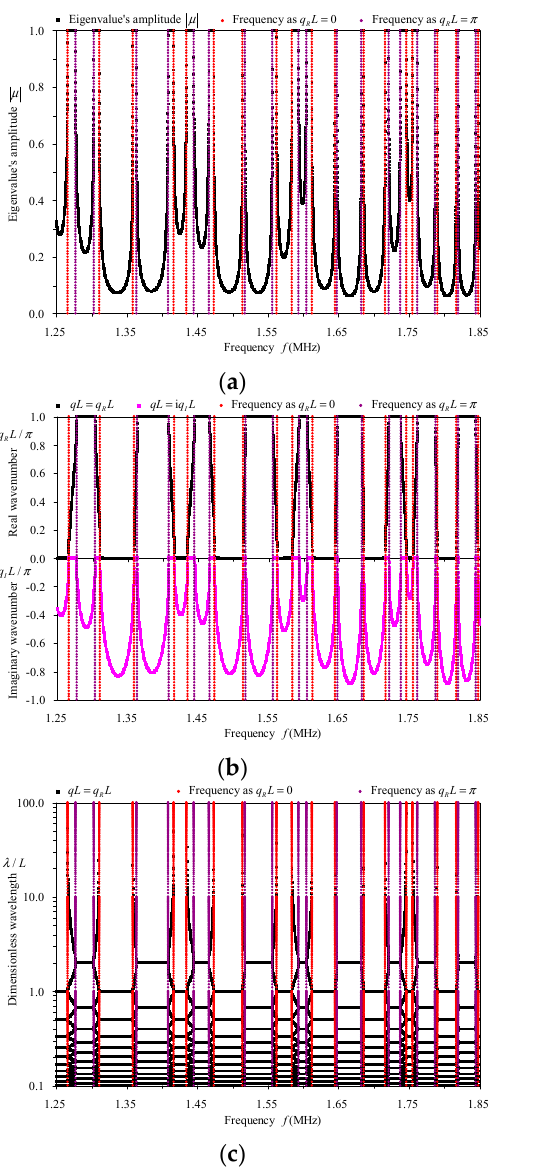
Figure 11. Various frequency-related dispersion curves of the periodic Epoxy-Brass-PZT-5H-Brass composite rod in high frequency range: ( a ) eigenvalue’s amplitude spectra; ( b ) wavenumber spectra; ( c ) wavelength spectra in logarithmic coordinate; ( d ) phase velocity spectra in logarithmic coordinate; and ( e ) phase velocity spectra in a small scale.